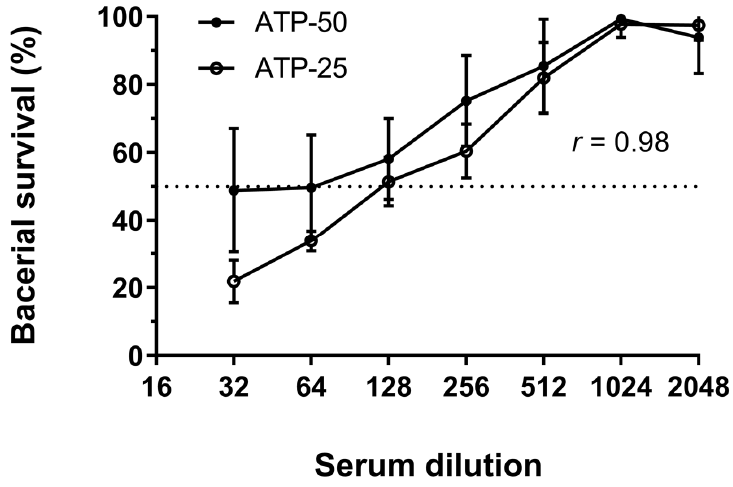
Figure 3. Comparison of two different resuspension volumes for quantification of serum bactericidal antibody (SBA) by ATP. Pooled anti-sera from mice immunized with N. gonorrhoeae P9-17 OMVs was tested for SBA to N. gonorrhoeae P9-17. Data are combined means ± SD from three independent experiments with 50 µL (ATP-50) or 25 µL (ATP-25) of re-suspended bacteria used to quantify ATP levels. The correlation between the two volumes was calculated using a two-tailed Pearson coefficient ( p < 0.0001) and significant differences between paired sets of values were determined by multiple t -tests.